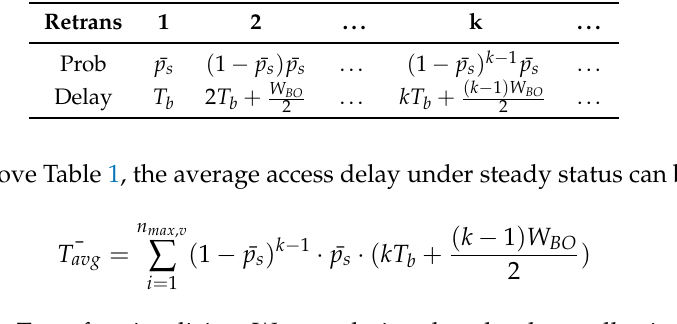
Table 1. ¯ T avg and probability for different retransmissions.